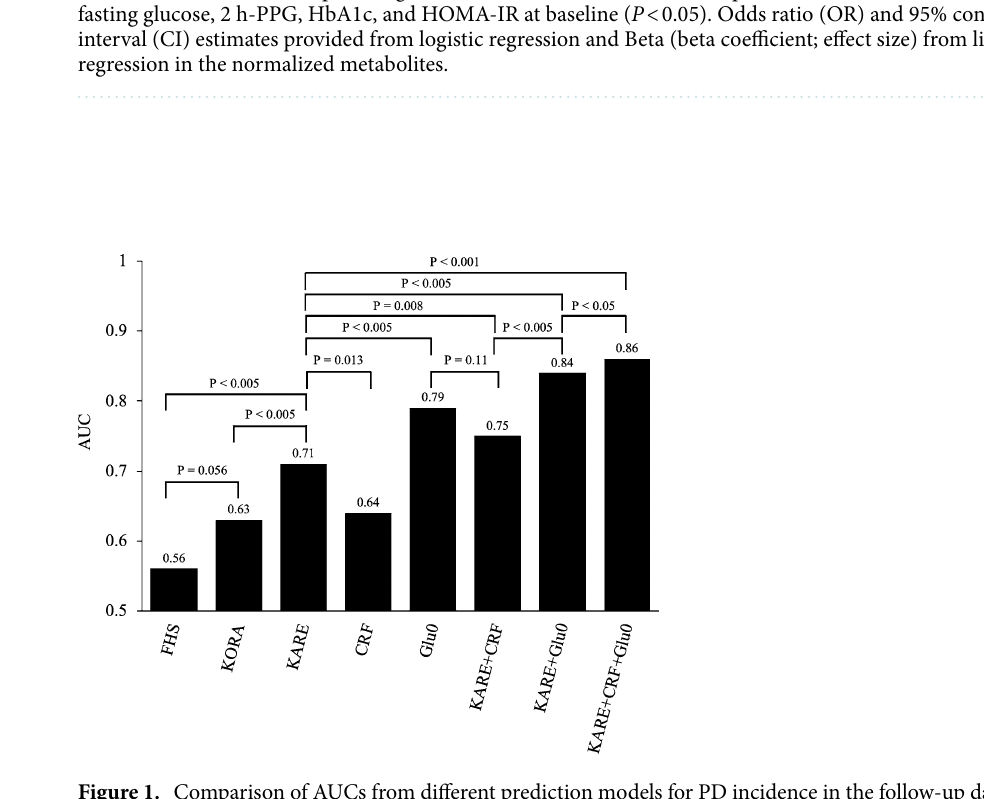
Figure 1. Comparison of AUCs from different prediction models for PD incidence in the follow-up dataset determined by DeLong’s test. FHS Framingham Heart Study model (Leucine, Isoleucine, Valine, Tyrosine,